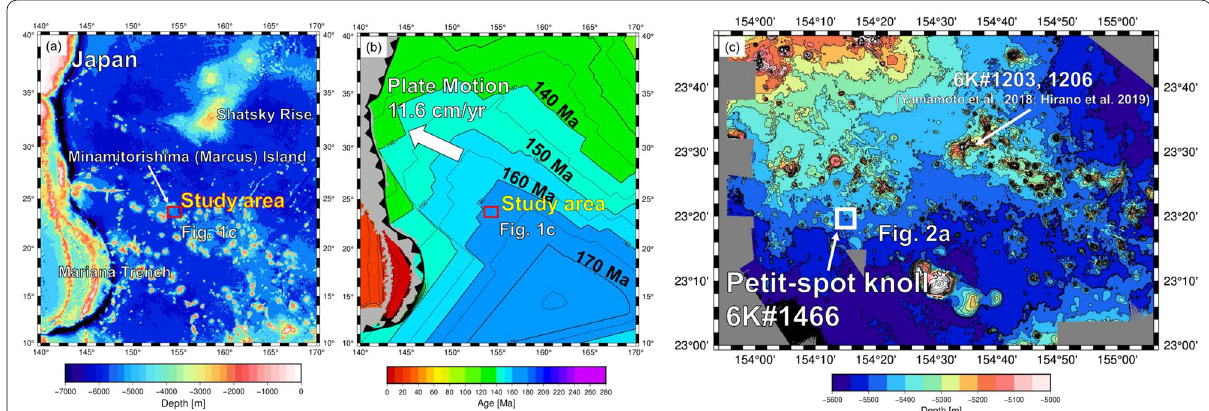
Fig. 1 Bathymetric and seafloor age map around the study area. a The bathymetry of the western Pacific near the Mariana Trench. The red box shows the study area, to the southeast of Minamitorishima (Marcus) Island. Bathymetric data are from ETOPO1 (NOAA National Geophysical Data Center; http:// www. ngdc. noaa. gov/). b The seafloor age map of same area as in ( a ). This study area is within a 160–170 Ma region called the Jurassic Quiet Zone (JQZ) (Tivey et al. 2006). The absolute motion of the Pacific Plate in this area is from Gripp and Gordon (1990). The seafloor age data are from Müller et al. (2008). c A detailed bathymetric map of the study area. The onboard multibeam data are from the YK10-05 cruise by JAMSTEC. The petit-spot knoll explored in this study, surveyed by the 6K#1466 dive, is displayed in a white box; that surveyed by dives 6K#1203 and 6K#1206 was reported by Hirano et al.